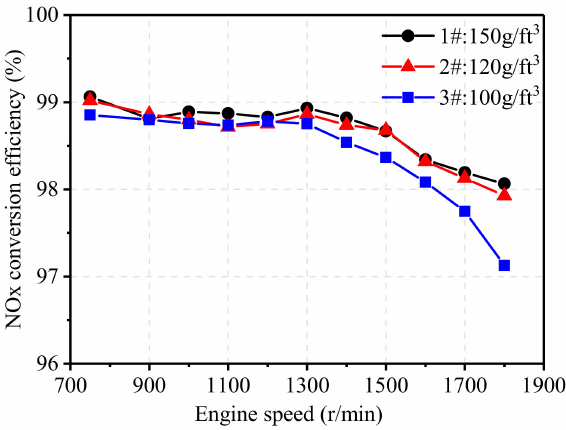
Figure 11. E ff ect of noble metal loading on NOx conversion e ffi